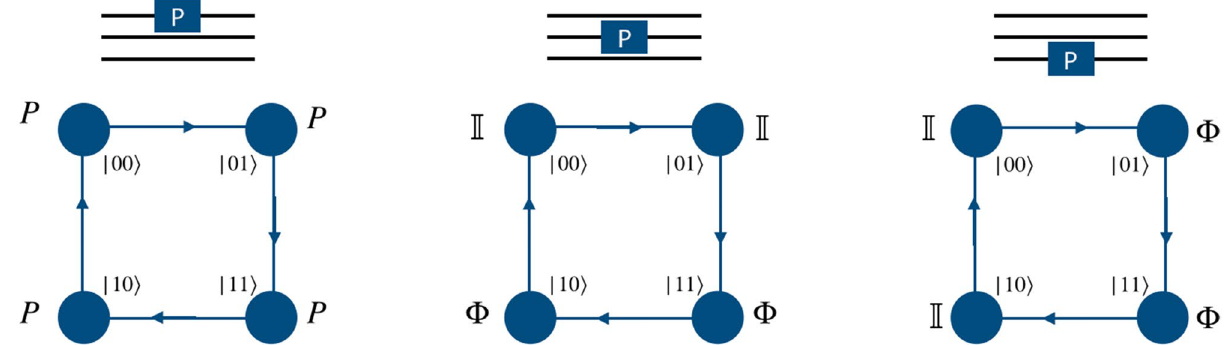
Figure 3. Schematic illustration for the realization of the phase gate on the computational basis of three-qubit system using a single particle quantum walk on four point position space using the position dependent coin operation on the real